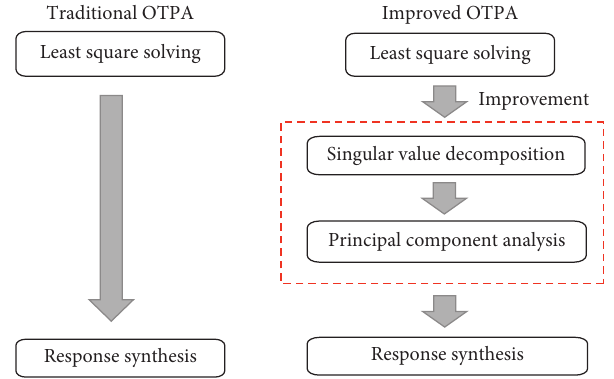
Figure 1: Framework of the traditional OTPA vs the improved OTPA.